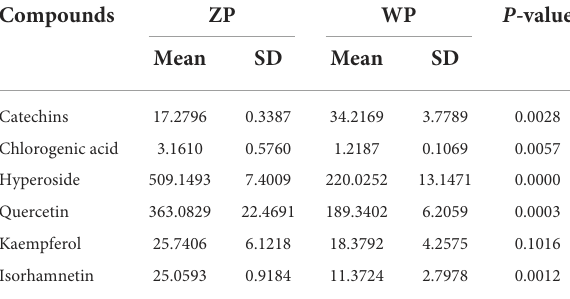
TABLE 4 Student’s t -test of component content between ZP and WP.